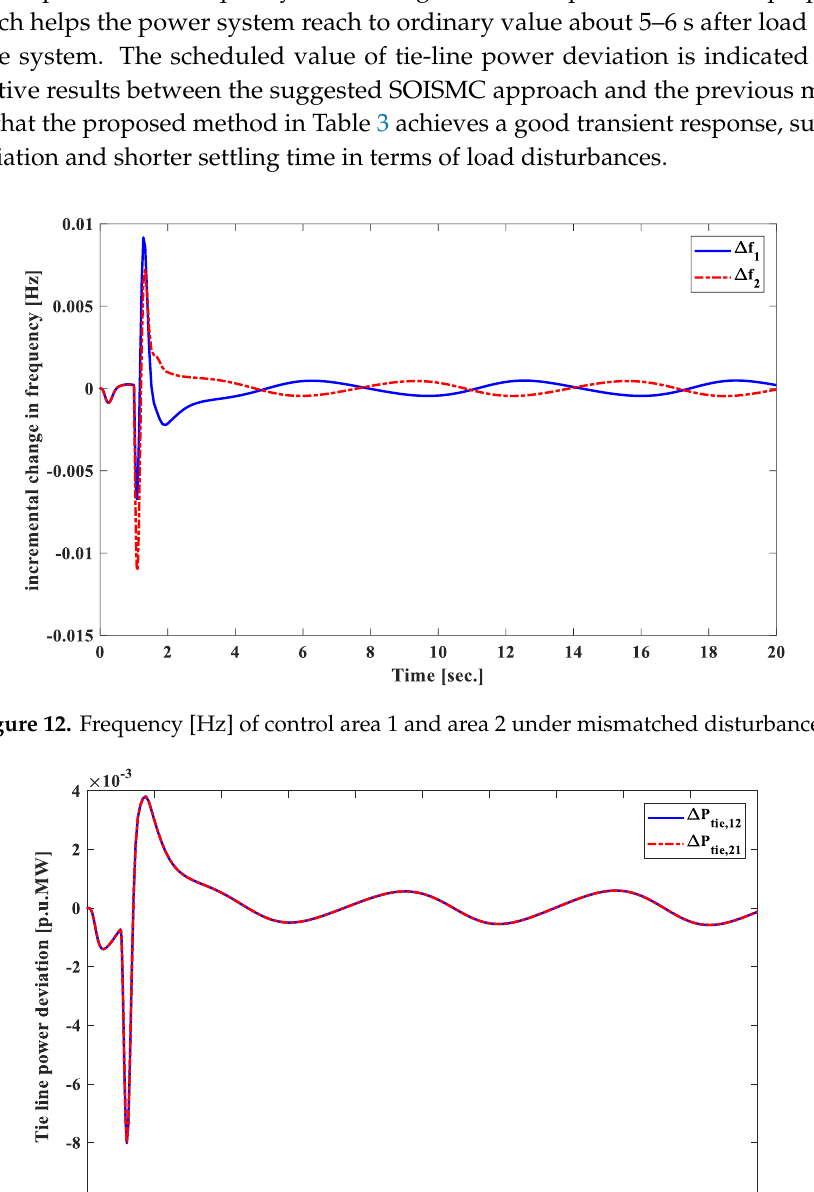
Figure 14. Control input [p.u.] of two control areas under mismatched disturbances.